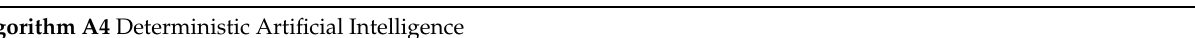
Algorithm A4 Deterministic Artificial